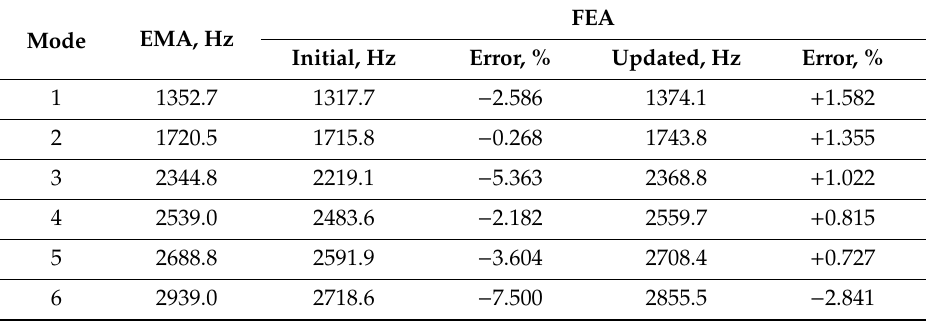
Table 4. Results of the FE model update.